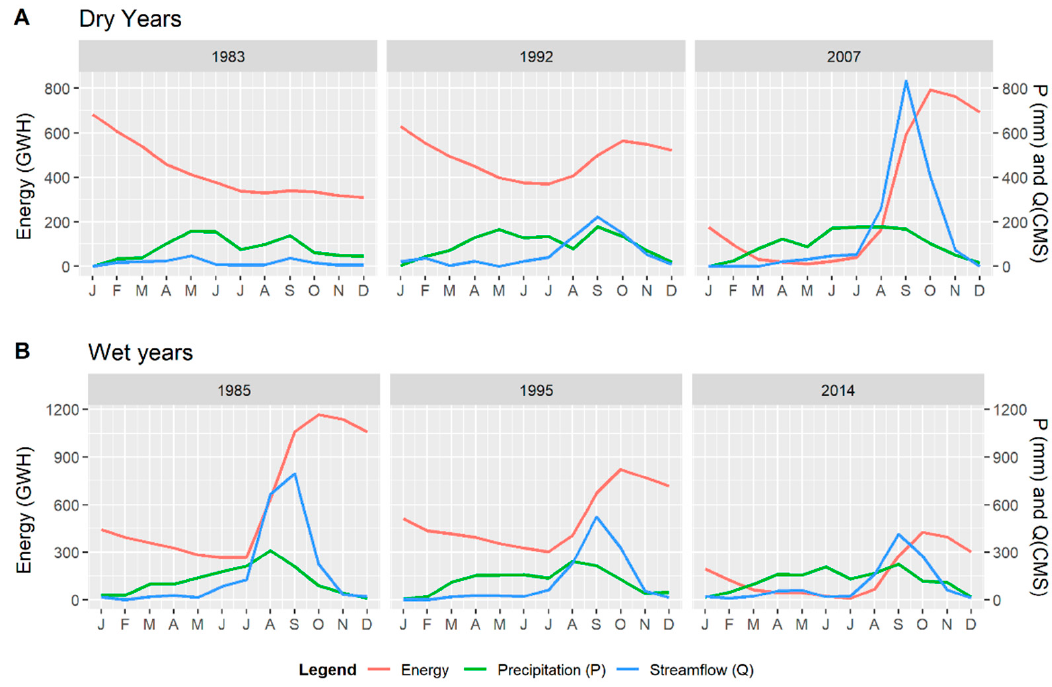
Figure 5. Monthly variation of total hydropower production (GWh in red), total GPCP precipitation (P in mm in green) in the basin and mean streamflow (Q in m 3 / s in blue) at Kossou hydrological station for three dry years (1983, 1992, 2007) and three wet years (1985, 1995, 2014) .